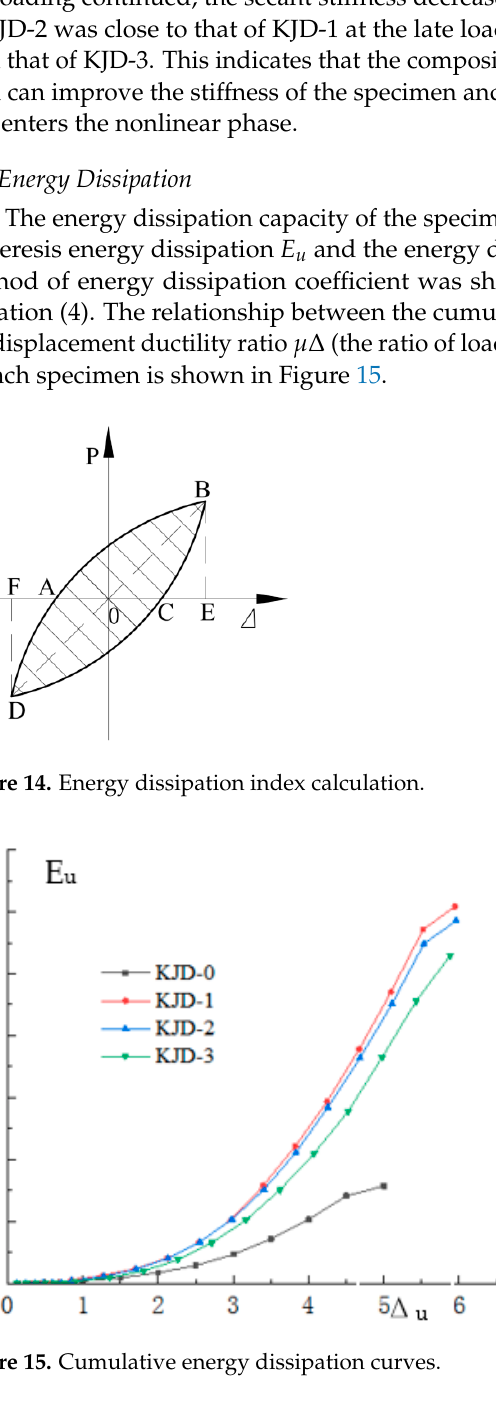
Figure 16. Energy dissipation coefficient curves. 4.5. Residual Displacement Ratio The unrecoverable permanent deformation of bridge pier after repeated loading is called residual displacement of bridge pier, and it is an important index for damage or repairability evaluation of bridge pier after earthquake. In this paper, the proposed resid- ual displacement coefficient R is used to analyze the residual displacement variation of each specimen [26]. R is calculated according to the following formula: 1